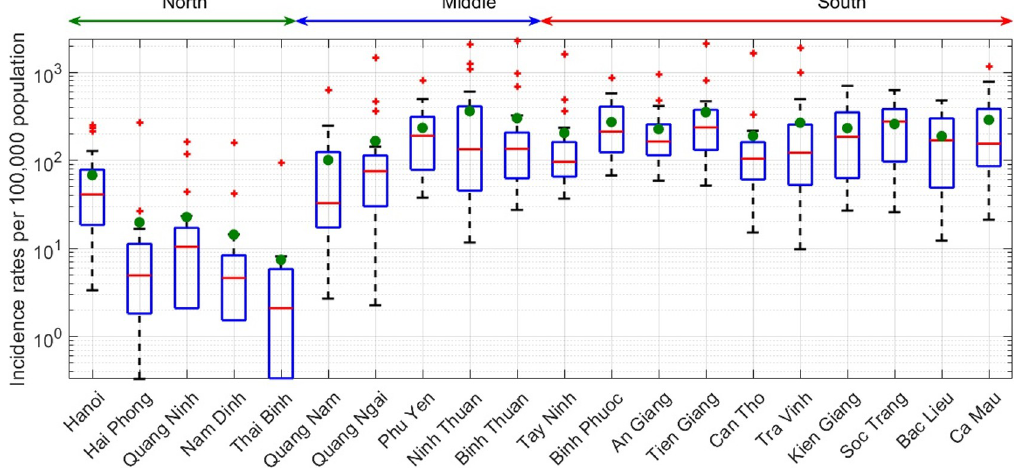
Fig 1. Yearly DF incident cases per 100,000 population (log-scaled) for 20 different provinces in northern, central, and southern Vietnam from 1997 to 2016. In the box and whisker plots, green dots indicate mean values.